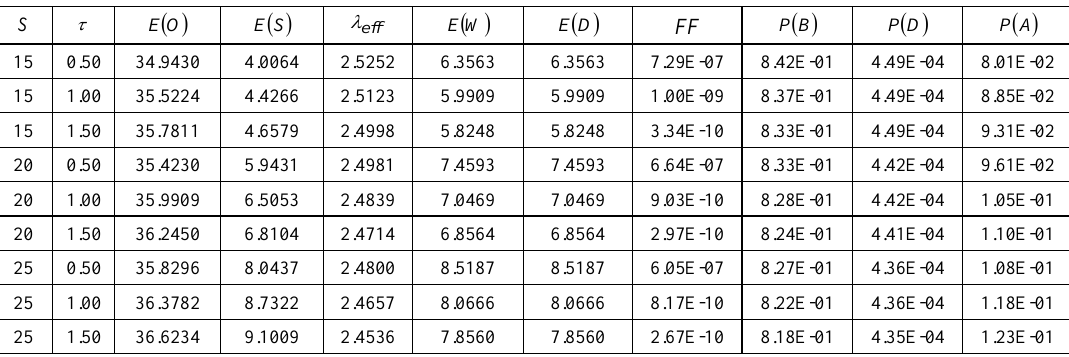
Table 4. Performance measures by varying the number of standby machines ( ) S and the setup time taken by the server ( ) 